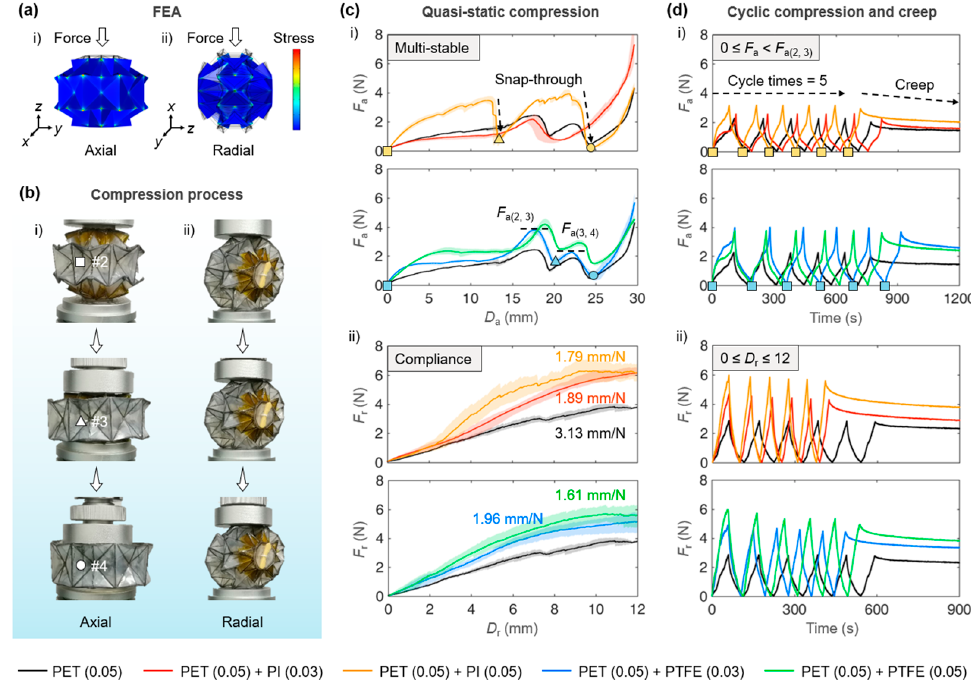
Figure 2d. In the axial direction, the stable configuration #2 can transition first to #3 and then to #4. Thus, #2 exhibited multi-stable axial quasi-static compression, as shown by (i) in Figure 4c. When F a > F a(2, 3) , #2 can be quickly converted to #3, and the force F a decreased significantly, which is called snap-through [51]. At this time, the Waterbomb had a negative stiffness ( K r < 0). When the thickness of origami materials was thinner, the difference in stiffness between all parts was small; #2 satisfied folding symmetry and could be converted directly to #4 without going through #3, as shown by (i) in Figure 4c (red curve). In the radial direction, #2 exhibited compliance with increased force, as shown by (ii) in Figure 4c. When the origami material was the same, the compliance decreased with the increase of the thickness of the origami material. Table 1 compares the K r of three groups; it can be found that the double-layer structure had a greater K r than the single layer, which contributes to the stability of the radial support.